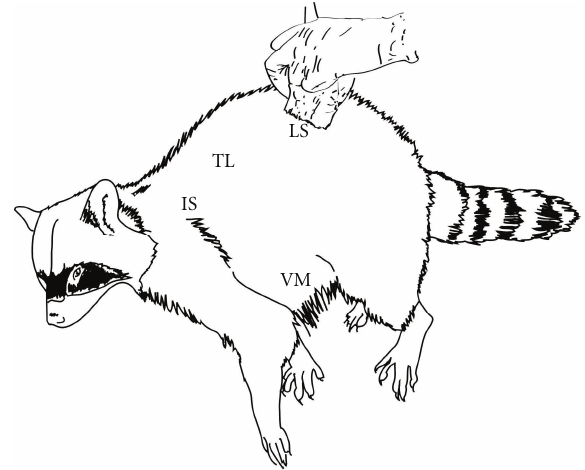
Figure 1: Diagram of ultrasound probe placement (IS = interscapu- lar, TL = thoracolumbar, LS = lumbosacral, VM = ventral midline).